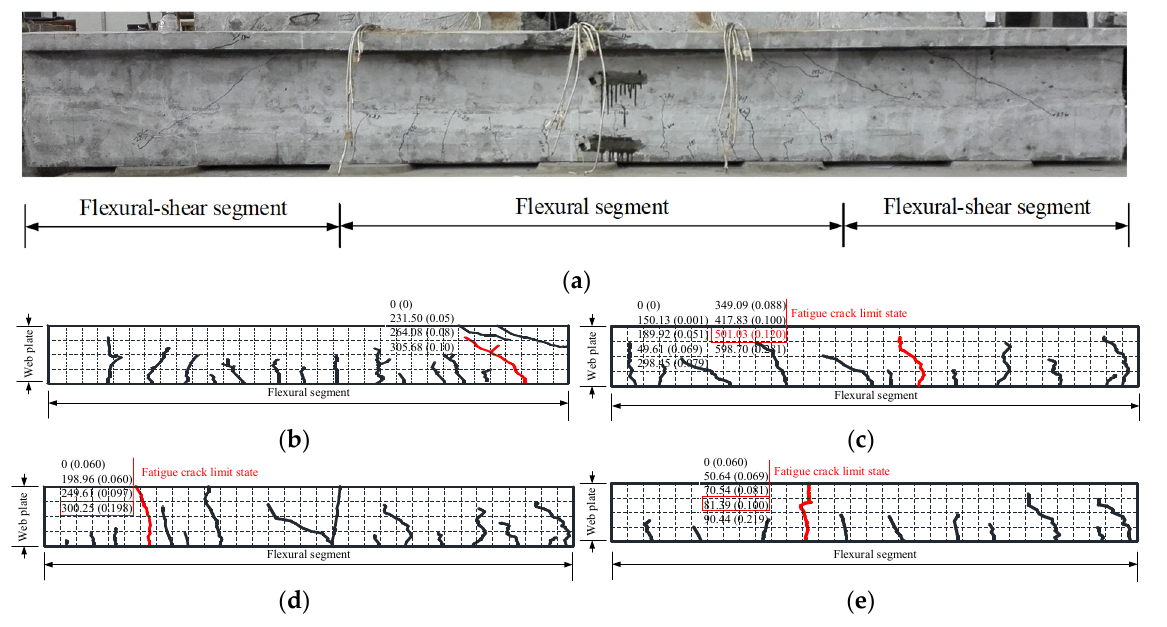
Figure 9. Crack distributions of the test beams (unit: mm): ( a ) General view (C1); ( b ) The test beam C1; ( c ) The test beam C2; ( d ) The test beam C3; ( e ) The test beam C4.